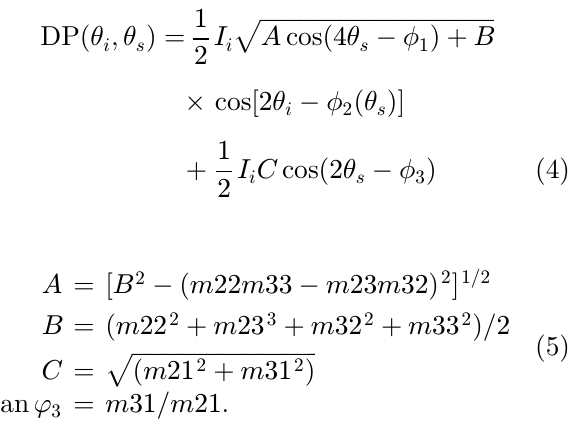
ffiffiffiffiffiffiffiffiffiffiffiffiffiffiffiffiffiffiffiffiffiffiffiffiffiffiffiffiffiffiffiffiffi ð m 21 2 þ m 31 2 Þ